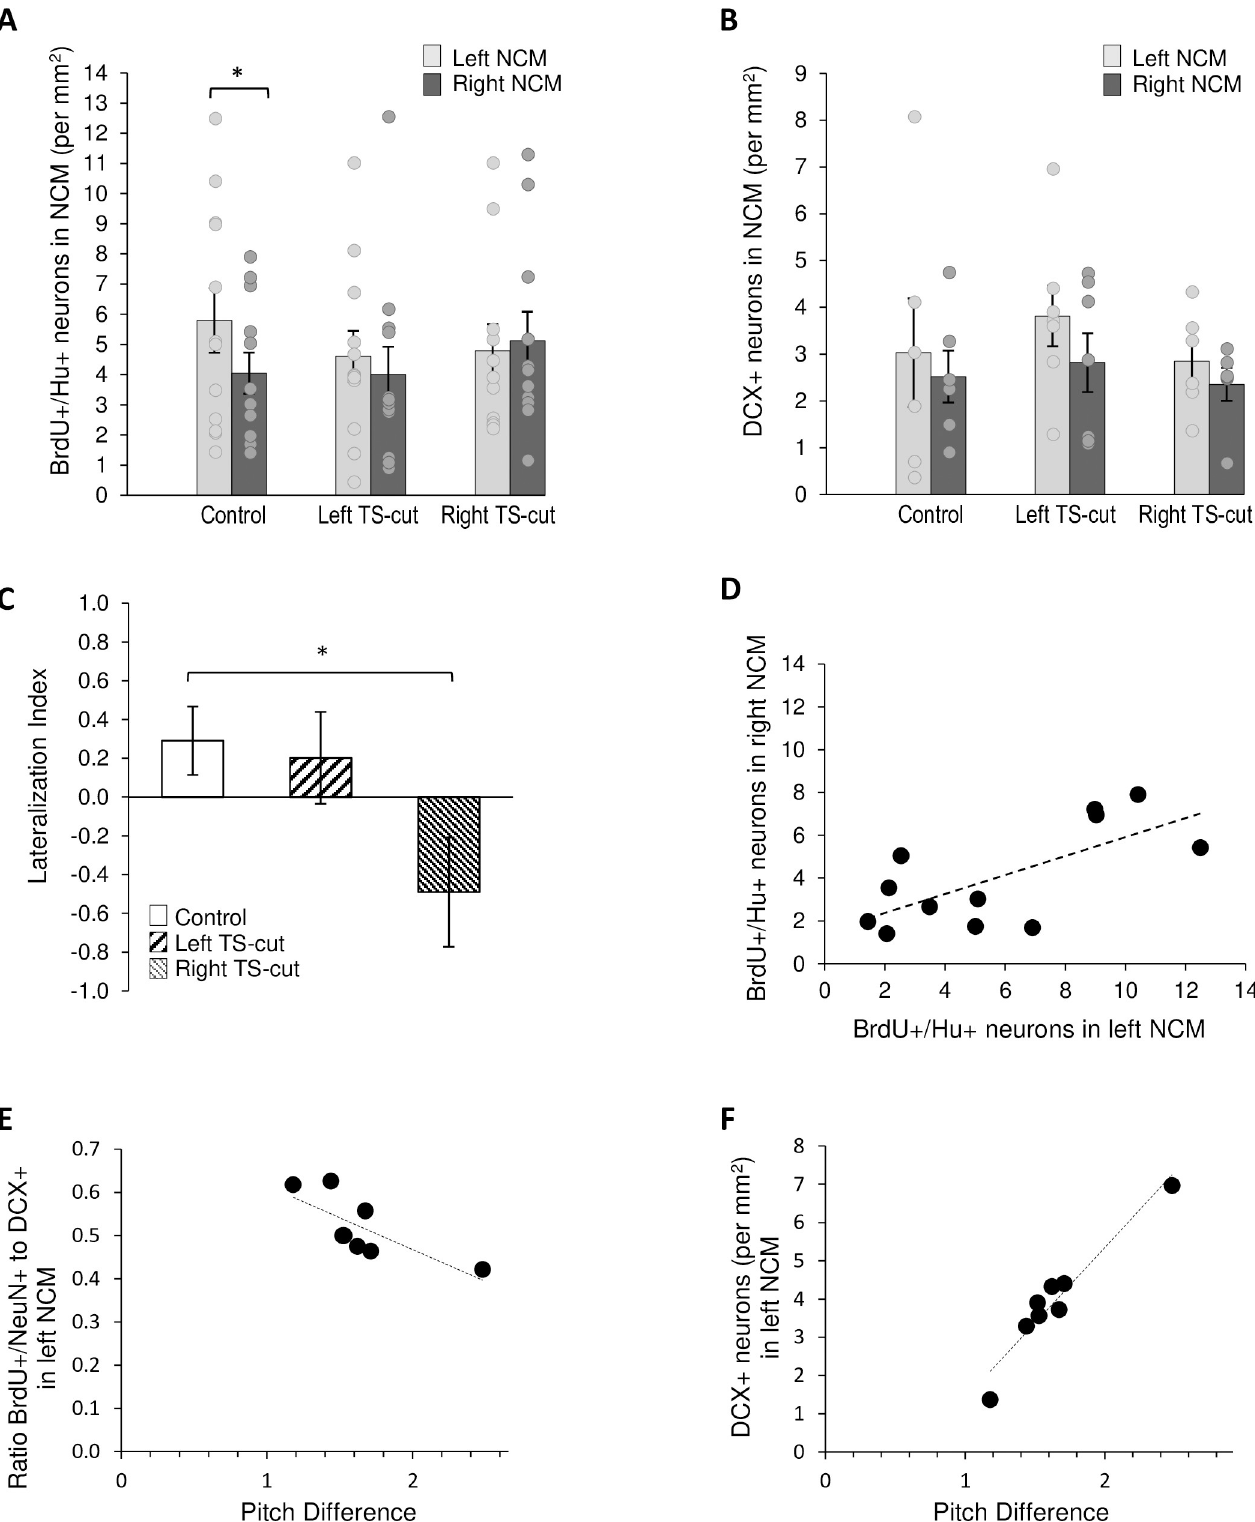
Fig 5. Numbers of new neurons in NCM as a function of hemisphere and experimental condition. A. Left (n = 12) and right (n = 11) TS-cuts had no effect on the overall number of 28–30 d old BrdU+/Hu+ neurons in NCM. Control birds (n = 12) had more BrdU+/Hu+ neurons in left NCM than the right and this